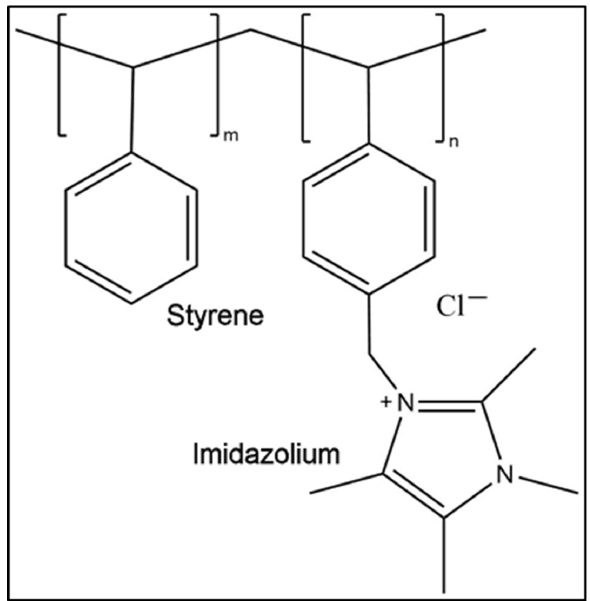
Figure 1. The structure of Sustainion ® membranes where an imidazolium-based cation is attached to a styrene backbone to create an immobilized ionic liquid material. C 2020 , 6 , x FOR PEER REVIEW